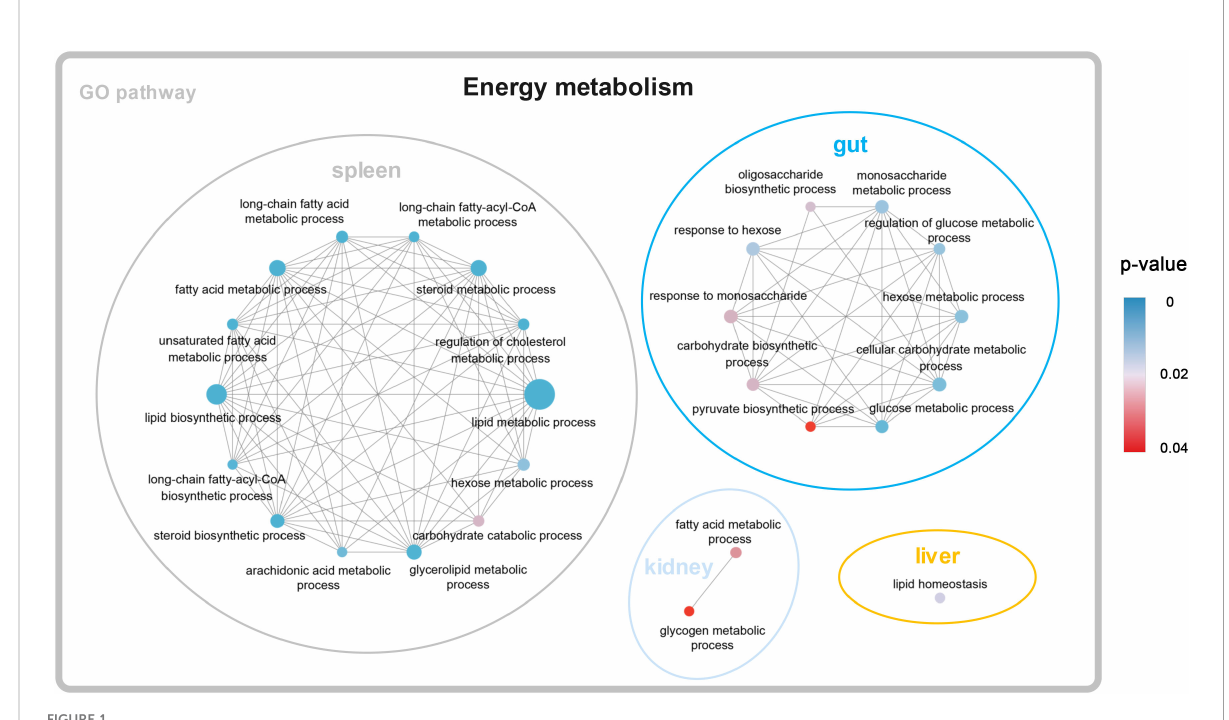
FIGURE 1 Signi fi cantly enriched KEGG items of DEGs (19°C group vs. 10°C